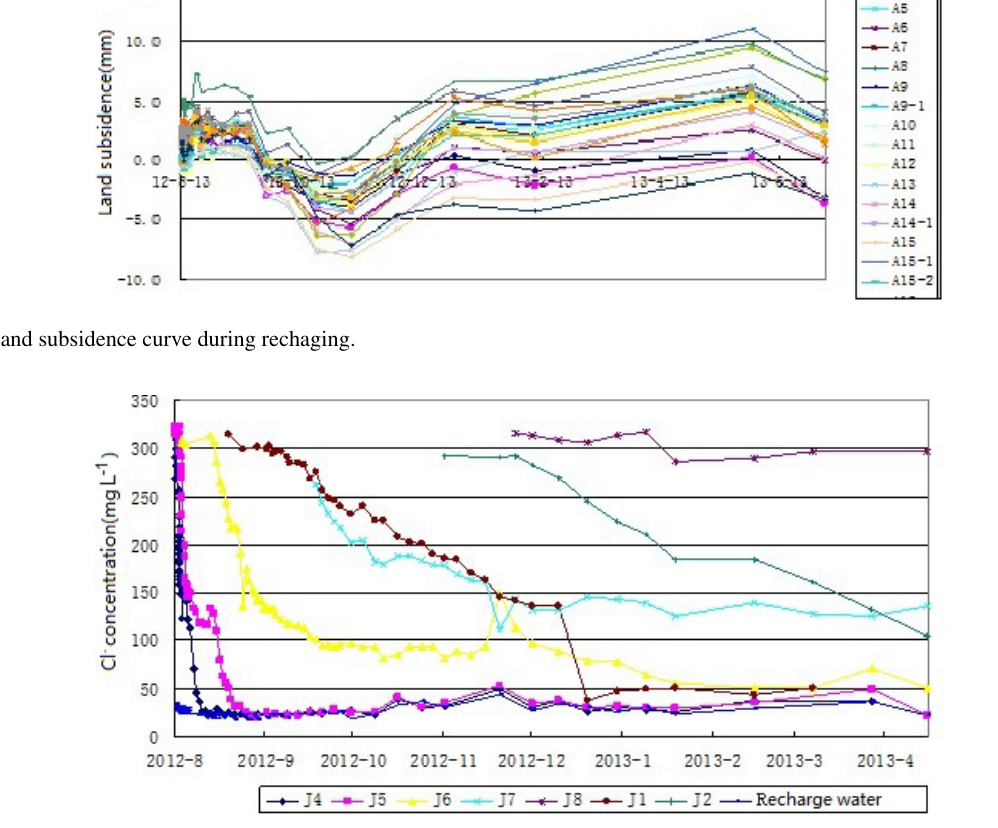
Figure 6. Concentration of Cl − curve in groundwater during recharging.